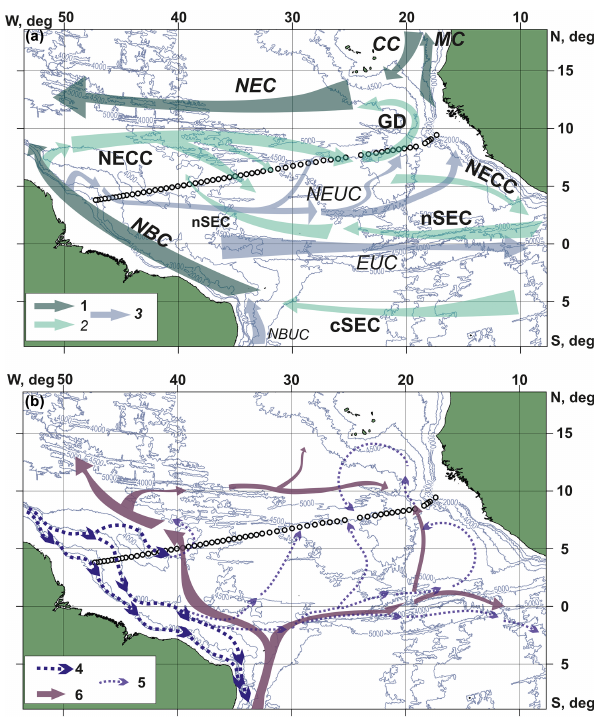
Figure 2. Generalized circulation schematics within the study area: surface and subsurface layers (a) and deep and bottom layers (b) , where 1 denotes surface currents (from 0 up to 100m), 2 de- notes subsurface currents (from 100 up to 500m), 3 denotes joint surface and subsurface currents (from 0 up to 500m), 4 denotes the Deep Western Boundary Current (DWBC) cores, 5 denotes schematic Deep Western Boundary Current recirculation, and 6 de- notes Antarctic Bottom Water. The references and current abbrevi- ations are explained in the text. White circles: Ioffe-2000 transect